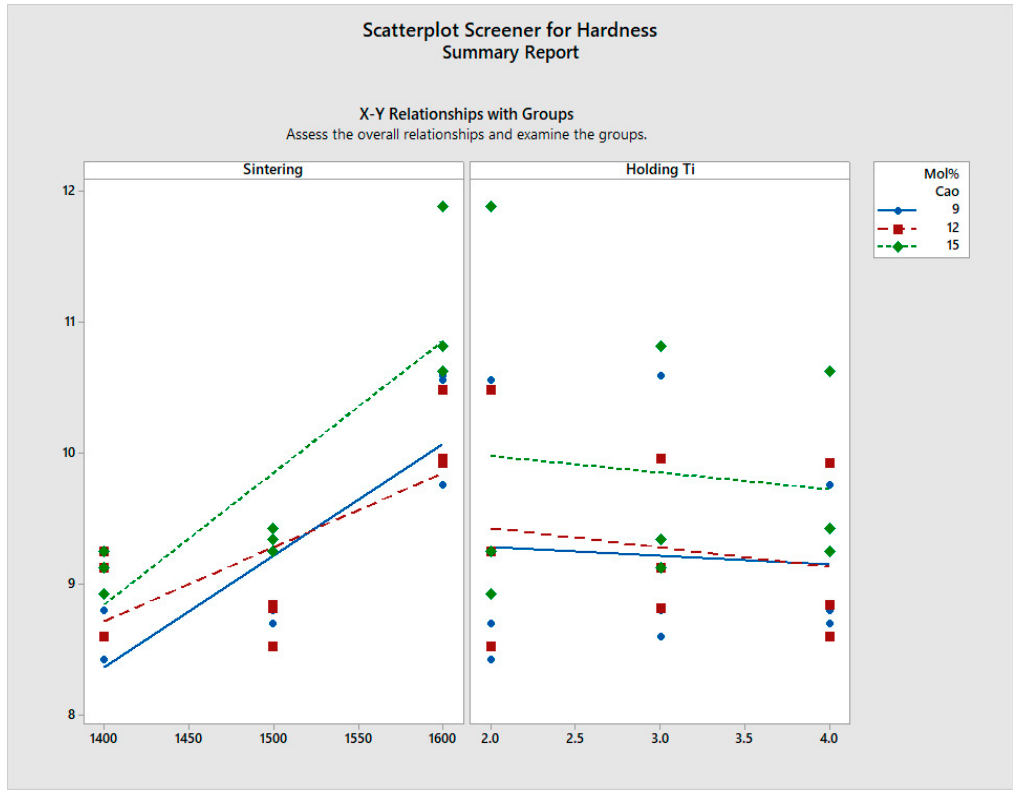
Figure 8. Effect of composition, sintering temperature, and holding time on hardness.